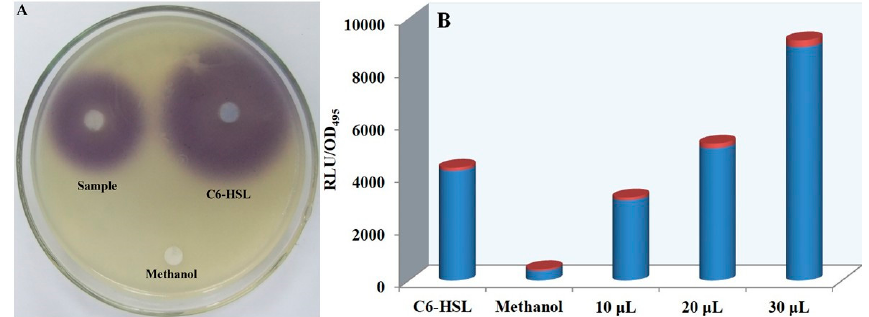
Figure 1. Detection of quorum sensing (QS) signal molecules secreted by Serratia odorifera with indicator strains. ( A ) Violacein detection by Chromobacterium violaceum CV026; ( B ) measurement of bioluminescence by Escherichia coli [pSB401].